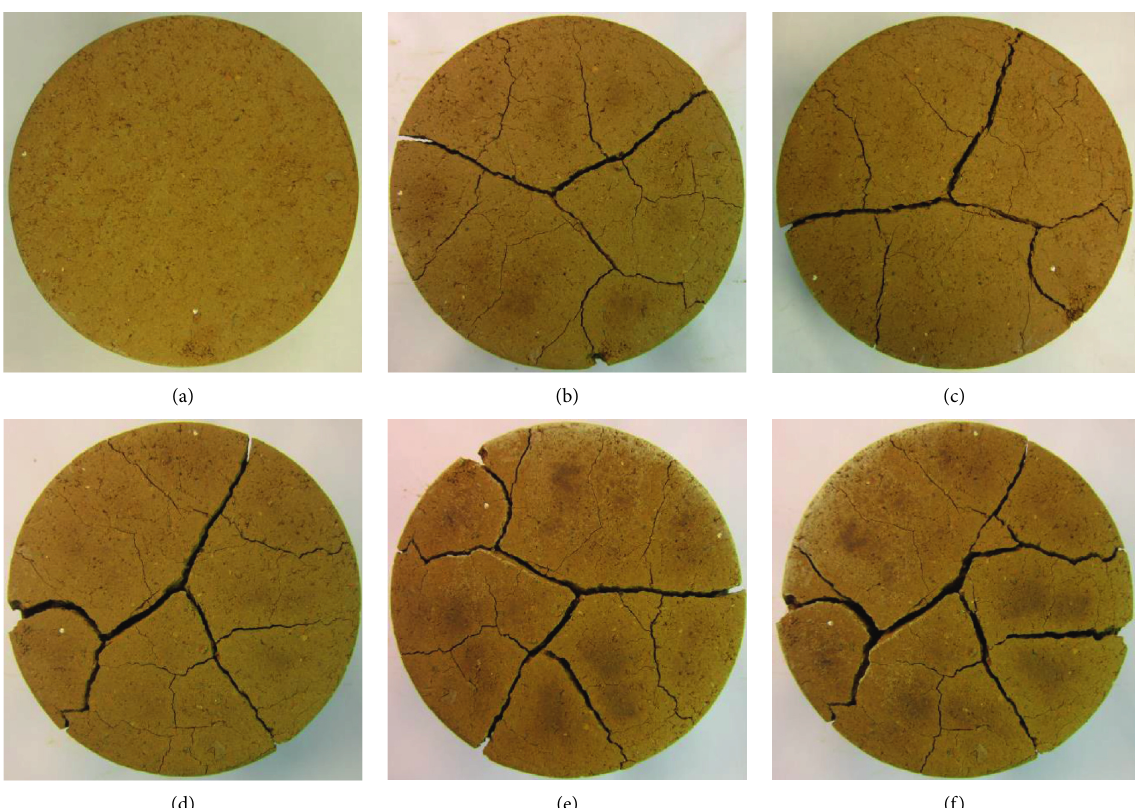
Figure 9: Images of crack development process in the verification test. (a) Zeroth cycle. (b) First cycle. (c) Second cycle. (d) Third cycle. (e) Fourth cycle. (f) Fifth